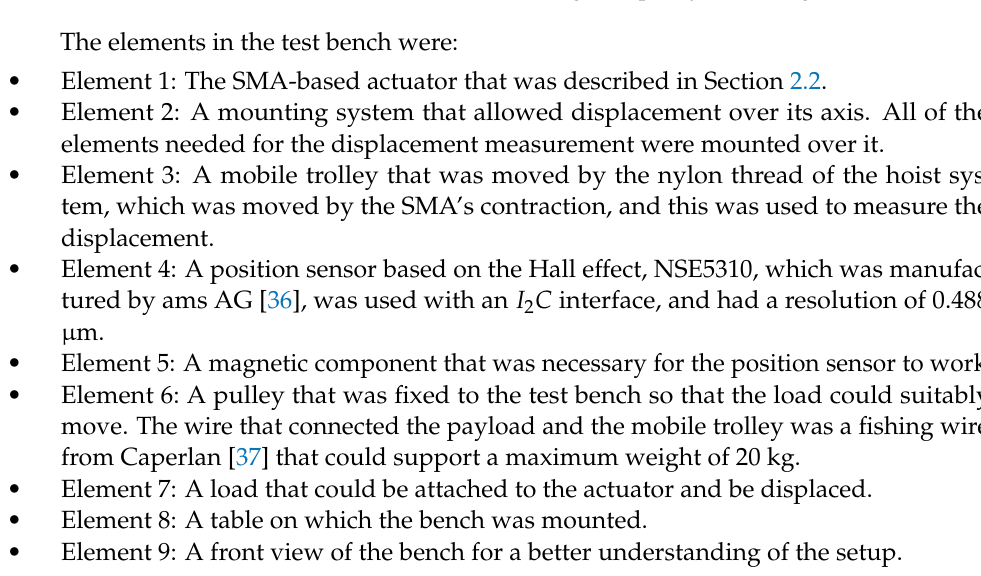
Figure 6. Outline and main components of the test bench. The mechanical system was composed of a mobile trolley that was pulled by the hoist system. Within, the sensors required for position measurement were mounted. The load was moved through the pulley on the edge of the